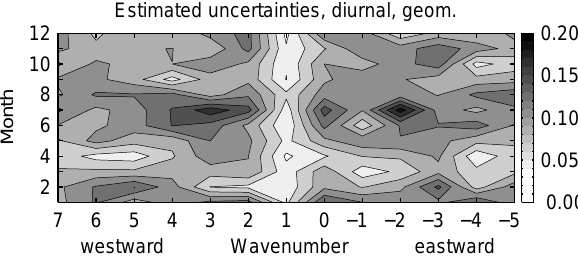
Fig. 5. Comparison of DE3 (red) and DE2 (blue) tides at the geo- magnetic (solid) and at the geographic (dash-dotted) equator. The biggest amplitudes of DE3 are reached along the geomagnetic equa- tor while DE2 is peaking along the geographic equator.